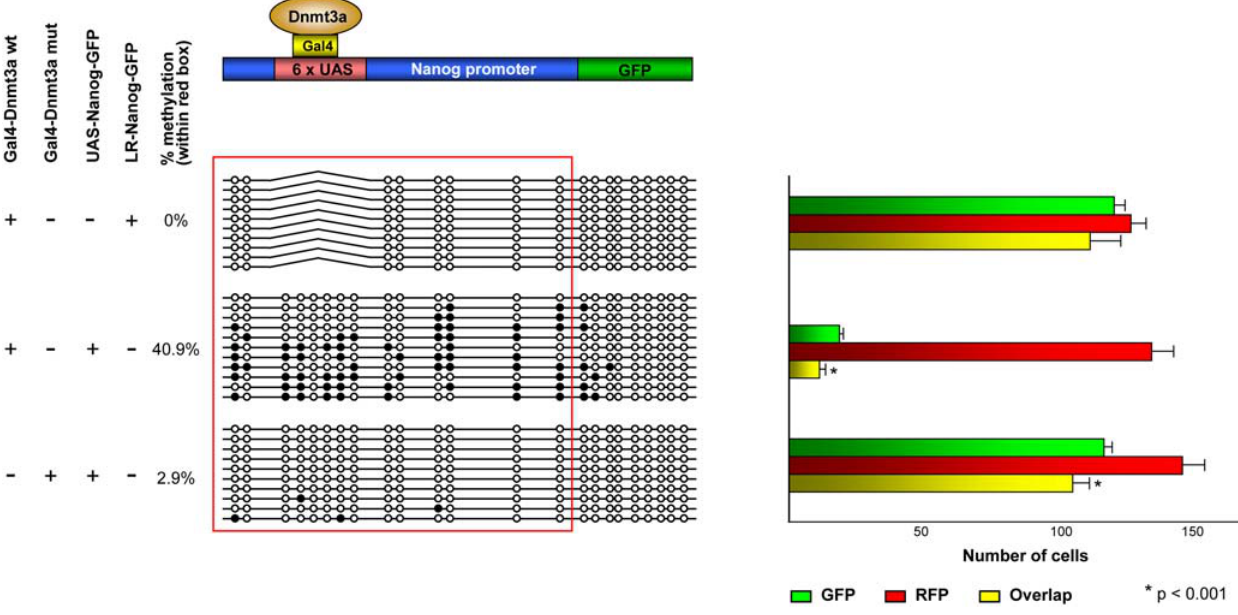
Figure 7. Targeted DNA methylation of the Nanog promoter in ES cells silences gene expression. A Nanog-GFP reporter plasmid with or without UAS targeting sequences was transfected into mouse ES cells together with a Gal4-Dnmt3a (wild-type or catalytic mutant) in addition to a pDsRed-C1 RFP construct as a transfection efficiency control. The number of GFP expressing cells (green bars), RFP expressing cells (red bars), and overlap between GFP and RFP expressing cells (yellow) was determined. Top row: transfection of Nanog-GFP without the UAS sequence together with Gal4-Dnmt3a results in high level (95.9%) GFP expression and 0% DNA methylation of the Nanog promoter (red box). Middle row: transfection of UAS-Nanog-GFP together with Gal4-Dnmt3a results in low level (14.5%) GFP expression and 40.9% promoter methylation. Bottom row: transfection of UAS-Nanog-GFP together with the catalytic mutant of Gal4-Dnmt3a results in high level (80.3%) GFP expression and 2.9% promoter methylation. Three independent transient transfection experiments were performed. P values (* indicates p , 0.001) were calculated by Student’s t -Test. The red box highlights the Nanog promoter region.